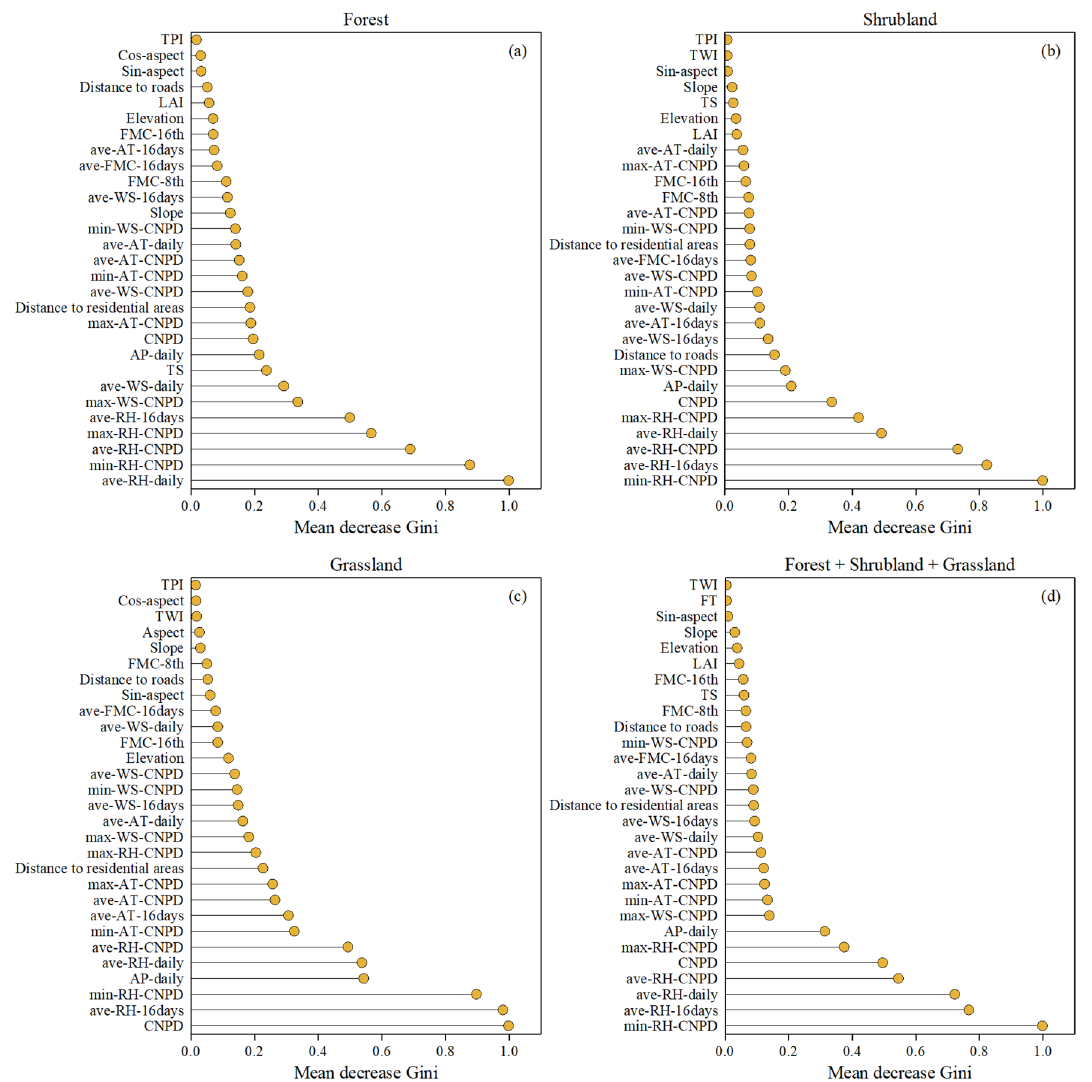
Fig. 3 Variable importance analysis for forest ( a ), shrubland ( b ), grassland ( c ), and all fuel classes ( d ), according to the mean decrease Gini index in random forest (RF) using the wildfire database. Note The mean Gini index was normalized, and its values ranged from 0 to 1. The top 30 variables are reserved. AP accumulated precipitation;